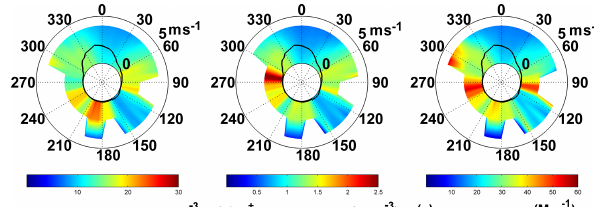
Figure 6. Wind rose plots of OC (a) , K + (b) , and σ abs , BrC , 370nm (c) . In each panel, the black solid lines denote the frequency of the wind direction. The shaded contour represents the average values of the corresponding species for that wind speed (radial length) and wind direction (transverse direction) in polar coordinates.